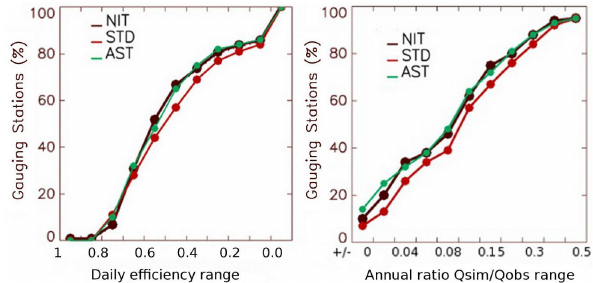
Fig. 4. Cumulative distributions of the (left) Eff score and (right) | 1 − Q | values of daily river discharges simulated by the sim /Q obs TRIP model driven by the NIT LSM option for several input precip- itation data sets. The black, green, turquoise blue and red lines rep- resent the simulations obtained with ERA-I-RG, ERA-I-G, ERA- I-R and ERA-I precipitation, respectively. These distributions are computed from a dense observational network consisting of daily discharges at 150 gauging stations in the CNF area.